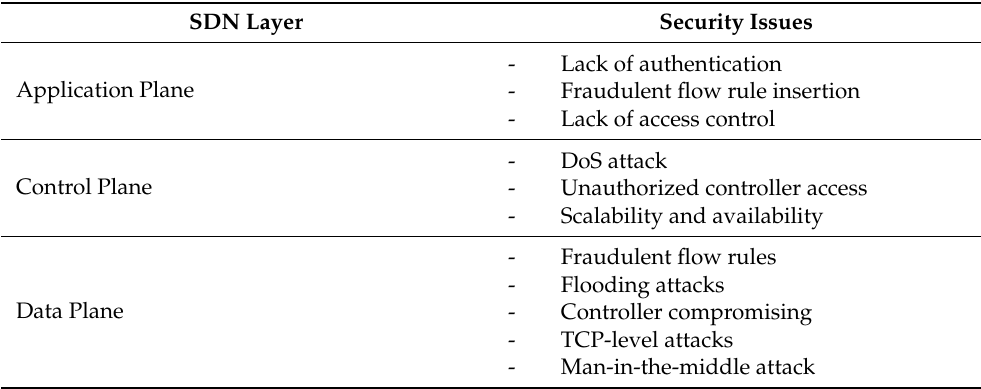
Table 1. Major SDN security issues for each SDN